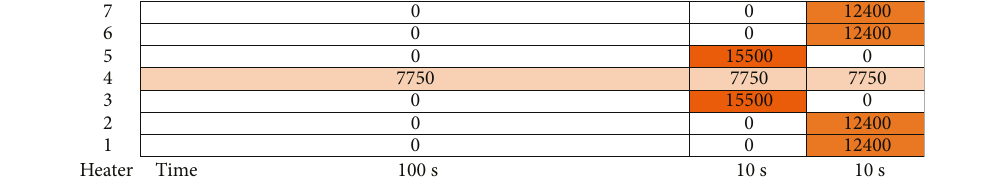
Figure 5: Heating sequence of NASA experiment (power in